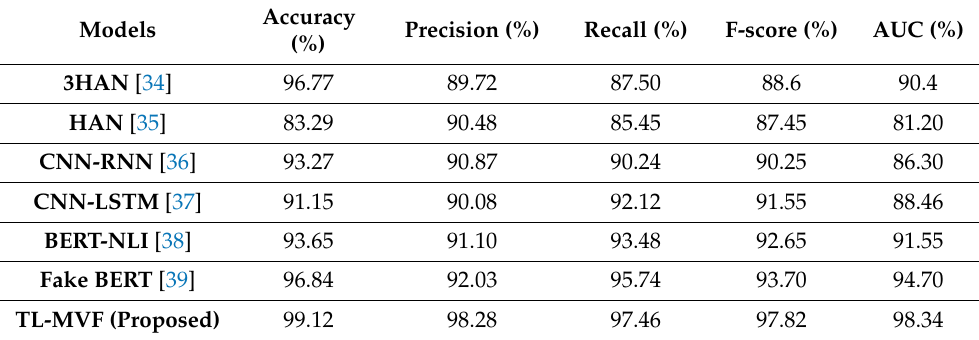
Table 6. Comparative results of the proposed TL-MVF with other mechanisms over Fake and Real News